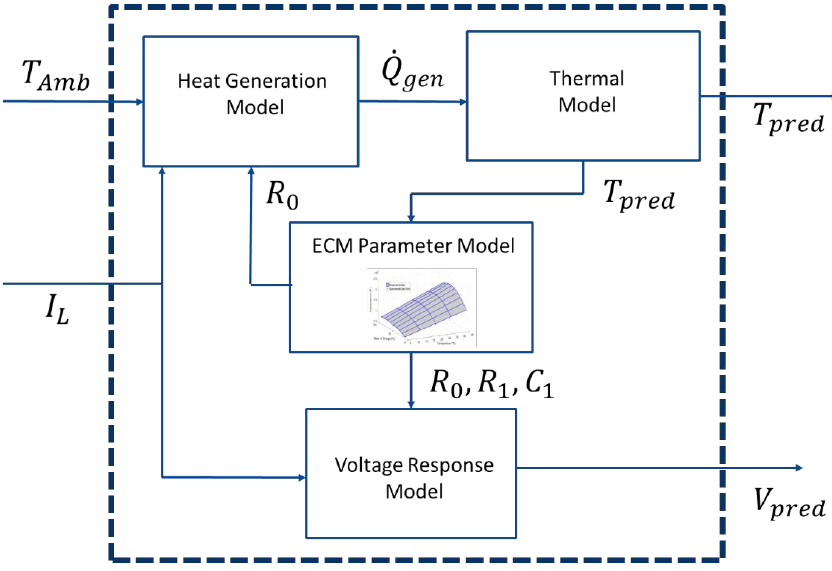
Figure 4. Overall comprehensive battery simulator with all four sub-models.